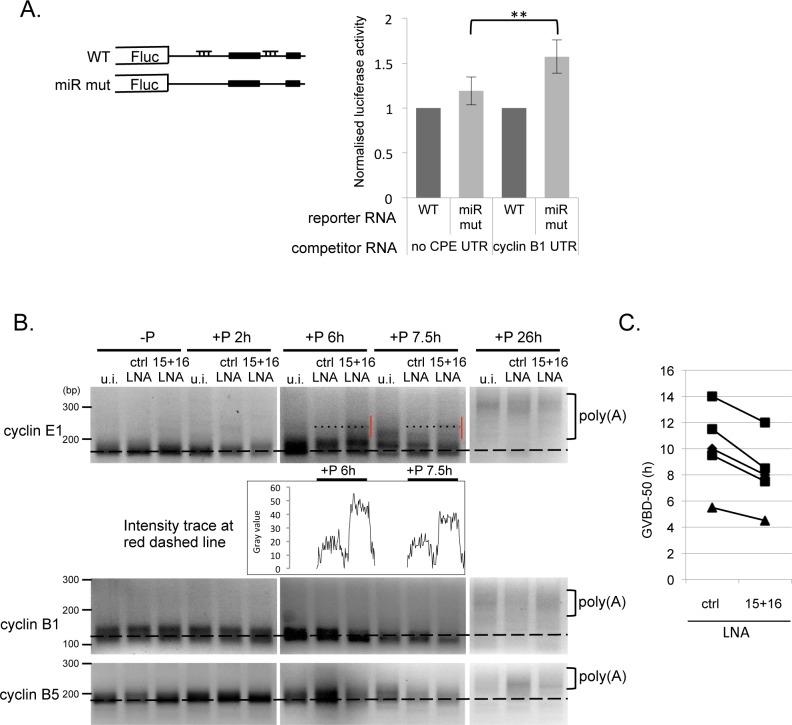
Inhibition of miR-15/16 causes premature polyadenylation of cyclin E1 mRNA and acceleration of meiotic maturation.A. Injection of a molar excess of CPE-containing RNA competitor enhances the effect of miR site mutations. 500 fmol of either a control 85 nt RNA not containing any CPE sequences (no CPE UTR) or a 65 nt 3’–terminal sequence of the cyclin B1 3’UTR (cyclin B1 UTR) were injected into stage VI oocytes. After an overnight incubation, oocytes were re-injected with either the WT or miR mut Firefly reporter constructs and the Renilla control RNA. The oocytes were lysed and assayed for luciferase after 6 h. The graph represents and average of 3 experiments with the WT reporter normalised to 1 in each case. (** P<0.01, 2-tailed paired t-test). B. Uninjected stage VI oocytes (u.i) or oocytes injected with control LNA (ctrl LNA) or a mixture of anti-miR-15 and anti-miR-16 LNAs (15+16 LNA) were incubated overnight, following which they were stimulated with progesterone. Samples were taken at indicated times. Extracted RNA was subjected to RNA-ligation coupled PCR polyadenylation analysis using primers for indicated mRNAs. Vertical red line indicates early polyadenylation in 15+16 LNA injected sample. Panel shows a representative experiment of 4. Graph underneath cyclin E panel depicts ImageJ profile plot taken along the dotted line. C. 100–150 stage VI oocytes were injected with either control LNA (ctrl LNA) or anti-miR-15 and anti-miR-16 LNAs (15+16 LNA) and incubated overnight and then treated with progesterone. GVBD was scored by the appearance of a white spot on the animal pole of the oocyte. The time required for 50% of the oocytes to achieve GVBD (GVBD-50) is plotted for 5 independent experiments.